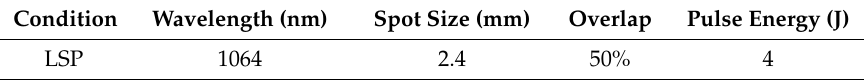
Figure 2. LSP-ed specimen showing the peened patch area. Table 4. LSP parameters utilized on Ti6Al4V titanium alloy.